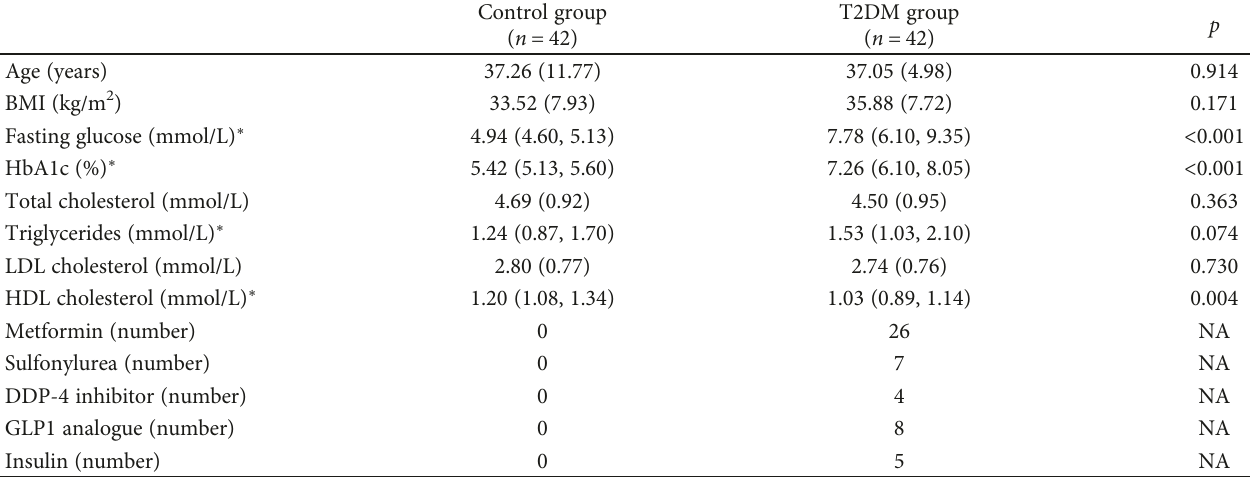
Table 1: Subject